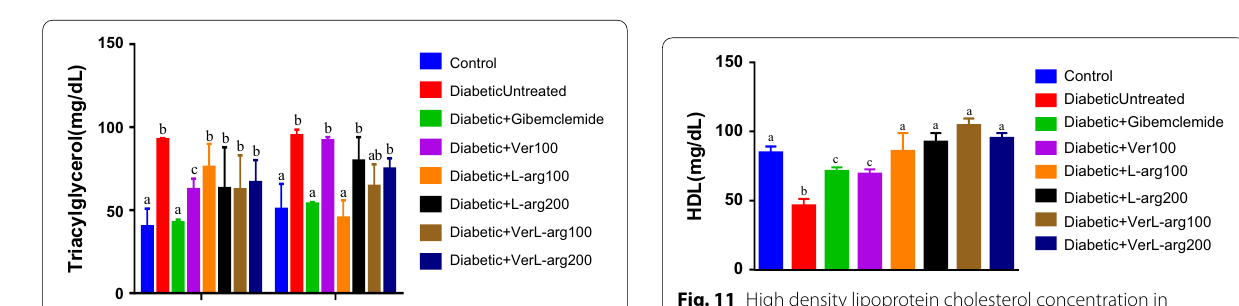
Fig. 11 High density lipoprotein cholesterol concentration in diabetic mice treated with verbenone, L-arginine and ratios of verbenone L-arginine (1:1 v/m) After 14 days treatment. Values are + L-arginine (1:1 v/m) expressed as mean SEM, n 5. Values with different superscripts are + ± = SEM, n 5. significantly different at p < 0.05. VerL-arg verbenone L-arginine ± = = + (1:1 v/m)